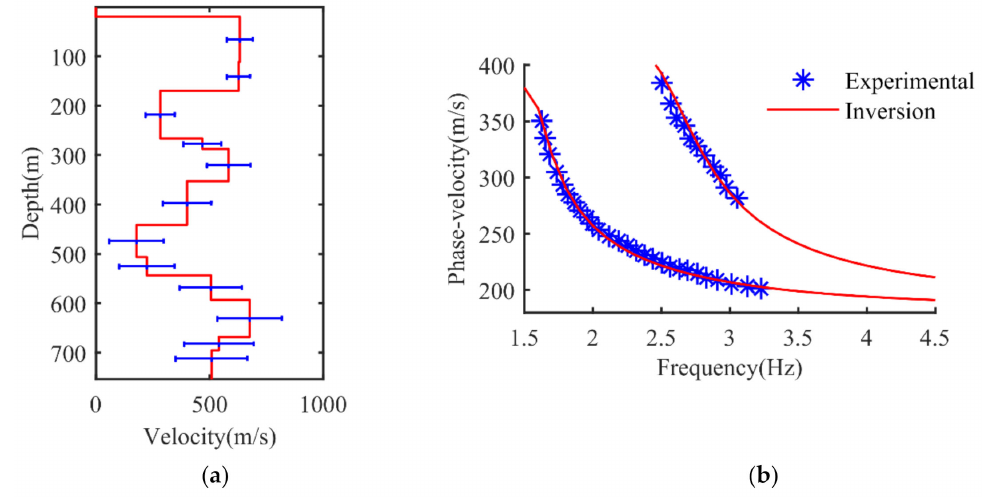
Figure 11. ( a ) Inversion results of shear wave velocity profile with an error bar. ( b ) Comparison between experimental and theoretical dispersion